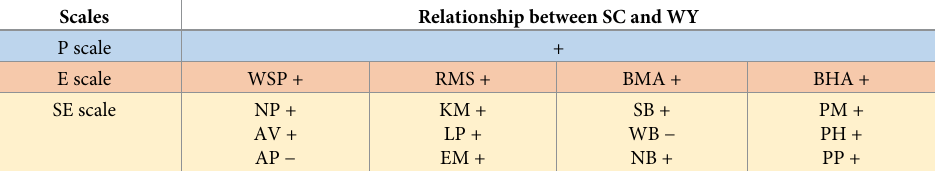
Table 6. The relationship between soil conservation (SC) and water yield (WY) at three spatial levels. “+” repre- sents synergy, and “ − ” signifies a trade-off.